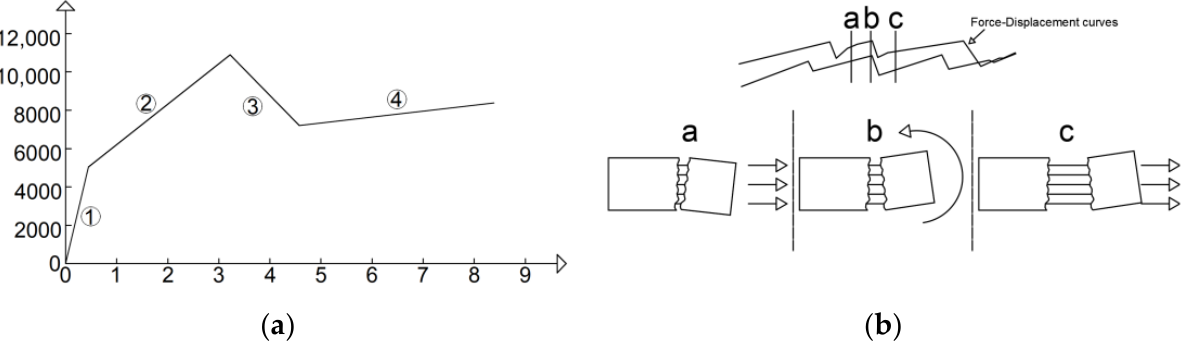
Figure 20. Simplified force – displacement curve of uniaxial tensile test on C-TRC specimens ( a ) and scheme of crack widening during the drop in load during stage 4 ( b ).